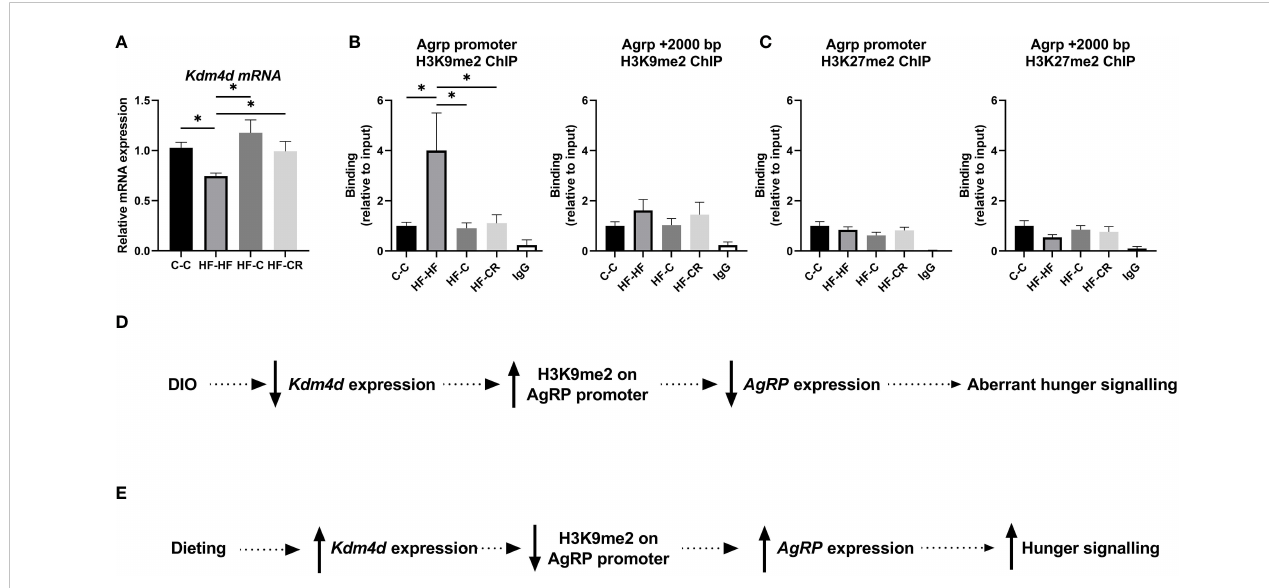
FIGURE 3 Dieting reverses the downregulation of histone demethylation on the AgRP promoter of obese rats, via changes in Kdm4d expression. (A) Kdm4d gene expression of the ARC was measured using RT-qPCR. Hprt expression was used as the standard gene to normalize all results. Relative gene expression in the C-C group was set to 1. (B) To check the histone methylation status of the target region, ChIP-qPCR was performed with anti-H3K9me2 and primers aligned to the promoter of AgRP and a control region 2000 base pairs downstream from the AgRP promoter. (C) To check the speci fi city of the histone modi fi cation location at the AgRP promoter, the enrichment of H3K27me2 was assesses using ChIP-qPCR, at the location of AgRP promoter and 2000 bp downstream. (D) Schematic presentation of proposed chromatin repressive pathway in obesity. In diet-induced obese rats, Kdm4d expression is downregulated leading to less demethylation of residue H3K9 at the AgRP promoter. The high abundance of repressive histone marker H3K9me2, leads to a downregulation in AgRP expression. This change in hypothalamic energy balance signaling partially effects the aberrant hunger signals in obesity. (E) However, this signaling is reversed through dieting. In dieting, Kdm4d expression is upregulated leading to more demethylation of residue H3K9 at the AgRP promoter. In the absence of a strong repressive marker, AgRP expression is upregulated, and rats exhibit a rebound, normal hunger signal. Data are presented as mean ± SEM. Signi fi cant effect between groups is indicated by *0.01 < P < 0.05 using ANOVA test with Tukey for multiple comparisons. For the ChIP experiments, the IgG was signi fi cantly different (P < 0.05) than the other groups, but not indicated for graphic